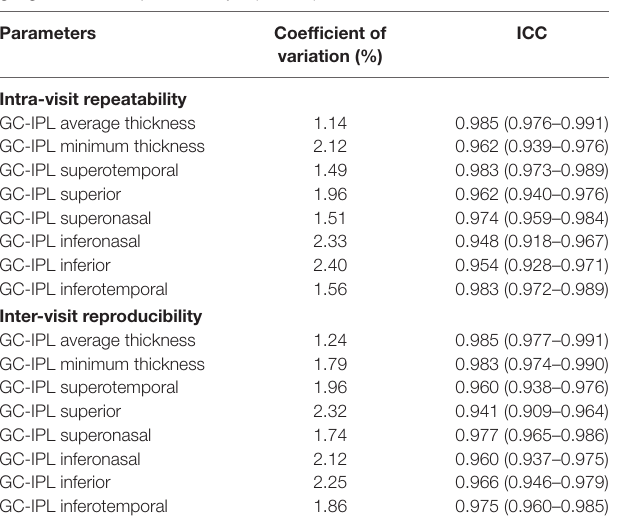
TaBle 3 | Intra-visit repeatability and inter-visit reproducibility of macular ganglion cell-inner plexiform layer (GC-IPL)